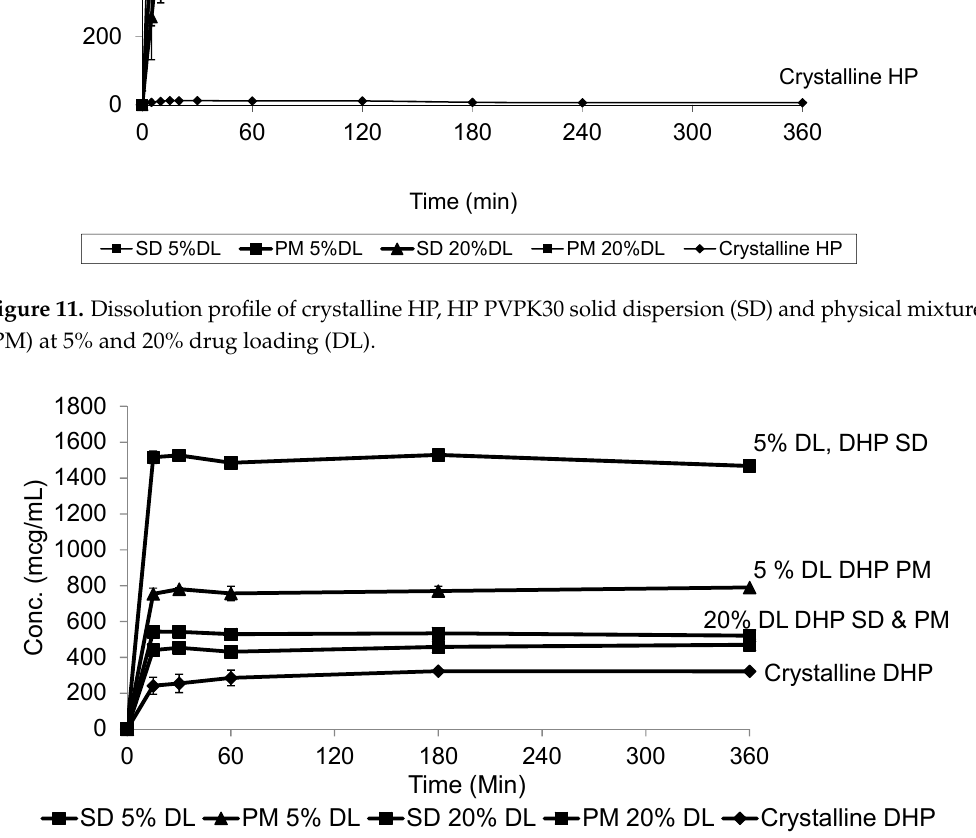
Figure 12. Dissolution profile of crystalline DHP, DHP-PVPK30 solid dispersion (SD) and physical mixture (PM) at 5% and 20% drug loading (DL).